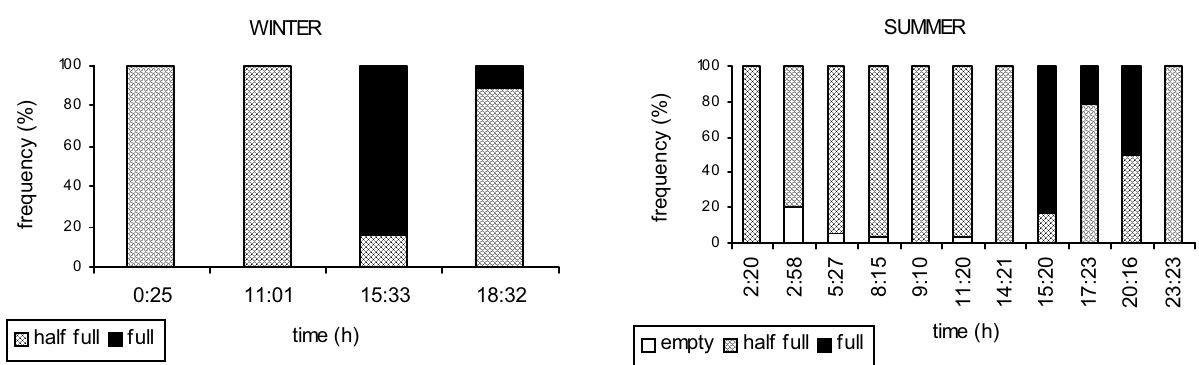
Fig. 3. Proportion of the stomach fullness levels of Trachurus lathami from Ubatuba shelf by sampling period in winter (22-24/ 07/1988 - 23 o 35.6´S/ 44 o 59´W) and summer (04-06/12/1988 - 23 o 51.3´S/44 o